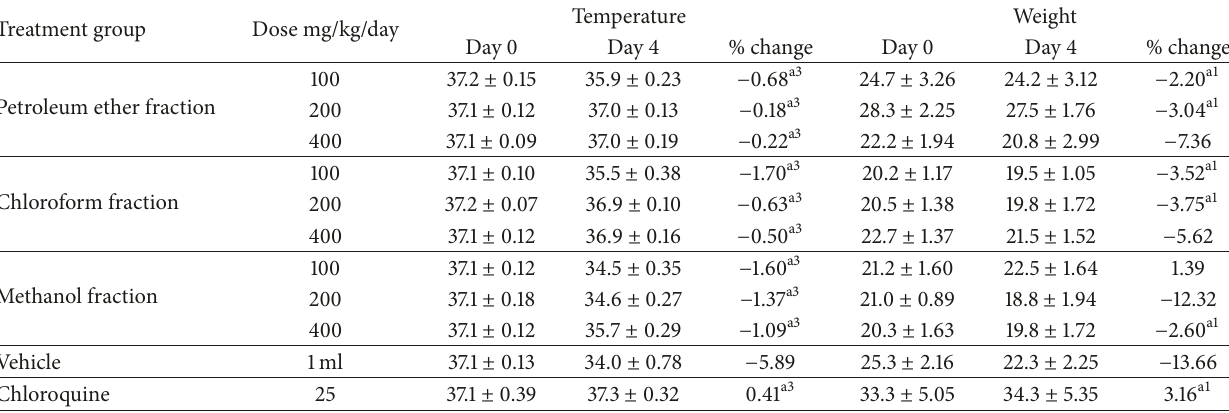
Table 6: Effect of the solvent fractions of C. papaya root on body temperature and body weight of P. berghei infected mice on 4-day Peter’s suppression test.